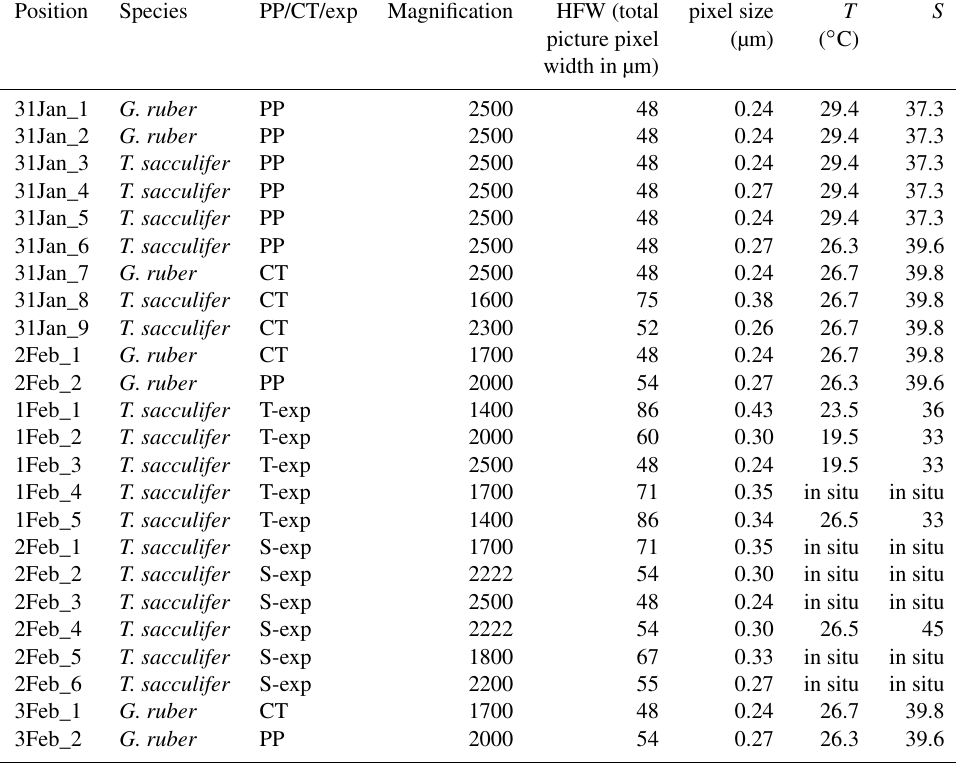
Table 1. List of characteristics of the EPMA measurements, excluding the multi-nets. The phrase “in situ” indicates that the measured chambers were not grown in culture, but formed in the natural environment 1.6–3.2km off the south coast of Curaçao ( S =∼ 35 . 9) before sampling. “PP” refers to Red Sea plankton pump samples, “CT” to Red Sea core-top samples and “exp” to